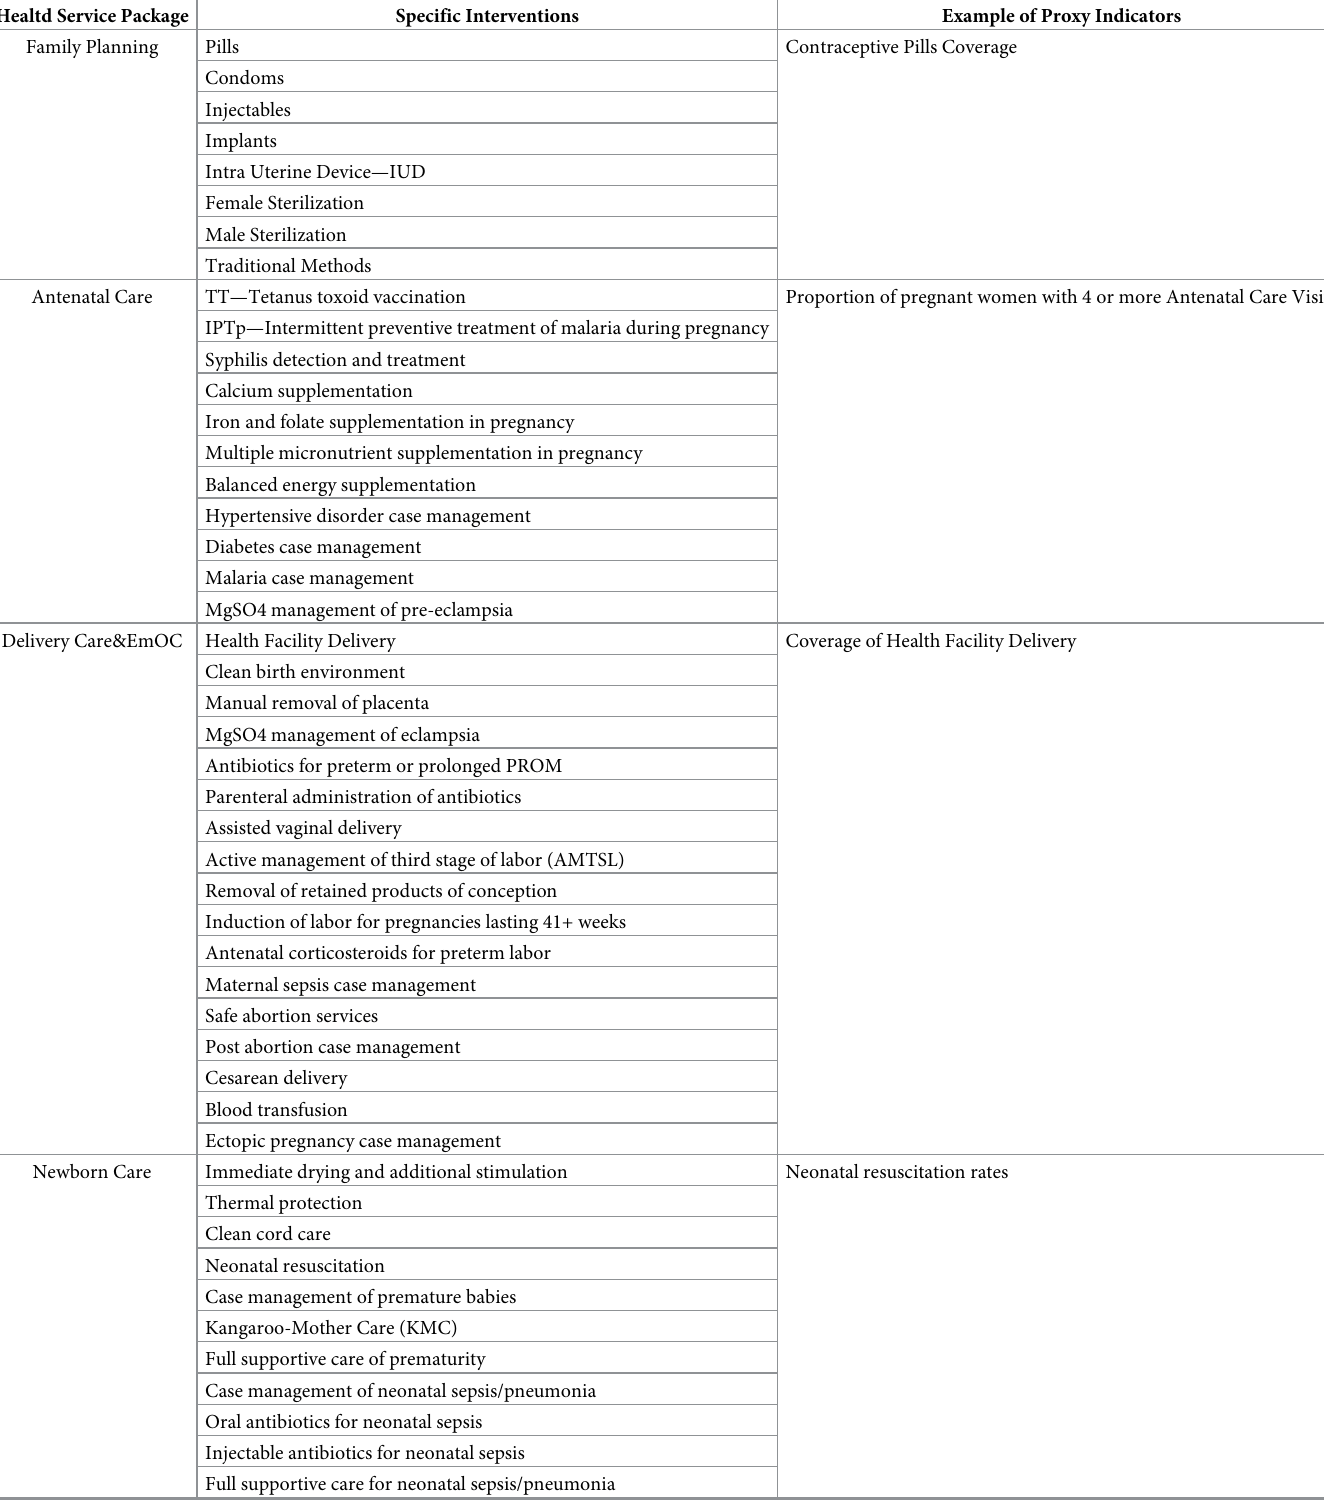
Table 1. Health service packages included in the analysis, interventions linked to each package and example of proxy indicators used. Healtd Service